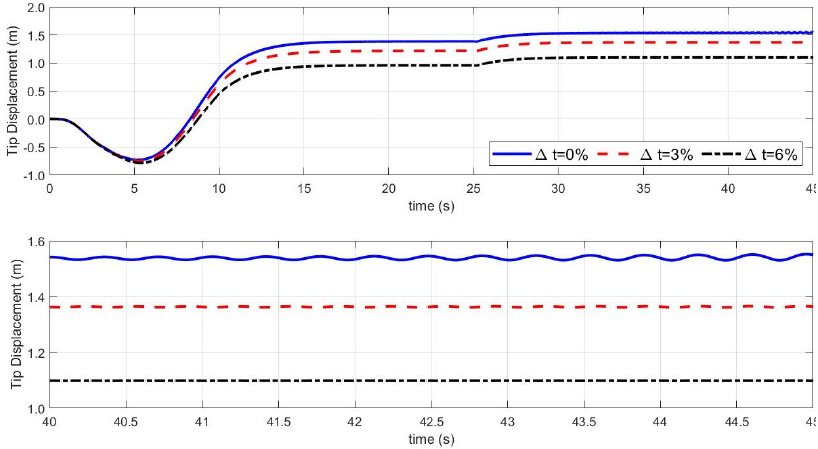
Figure 11. Tip response of the wing considering three different box beam thickness